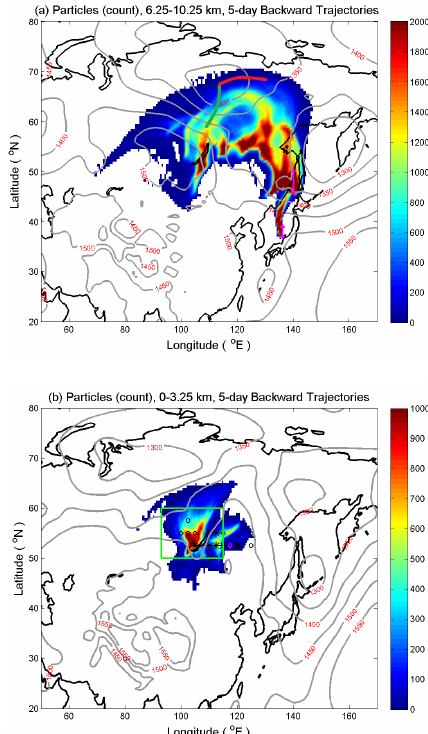
Figure 7. (a) Particle distribution between 6.25 and 10.25km ( ∼ 550–250hPa) during 1–6 June 2003. The particles were released from two locations (in pink lines) around 400hPa (also see Figs. 4a and 6a) on 6 June 2003 and backward trajectories were calculated. The contour lines are the geopotential heights at 850hPa on 3 June 2003. A cold front and a warm front are indicated by green and red lines, respectively. (b) the same as (a) , but between 0 and 3.5km. The contour lines are the geopotential heights at 850hPa on 2 June 2003. The circles, diamonds, and stars denote daily mean fire counts of 20–100, 100–300, and 300–500 per 2.5 ◦ × 2.5 ◦ grid area, respec- tively, from 31 May to 6